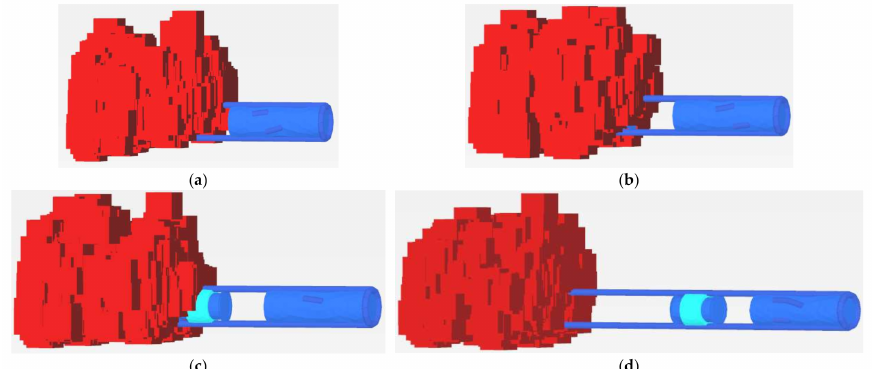
Figure 9. Plastic zone according to separation distance between the blasting point and the protection shield: ( a ) Case 1-1, ( b ) Case 1-2, ( c ) Case 1-3, and ( d ) Case